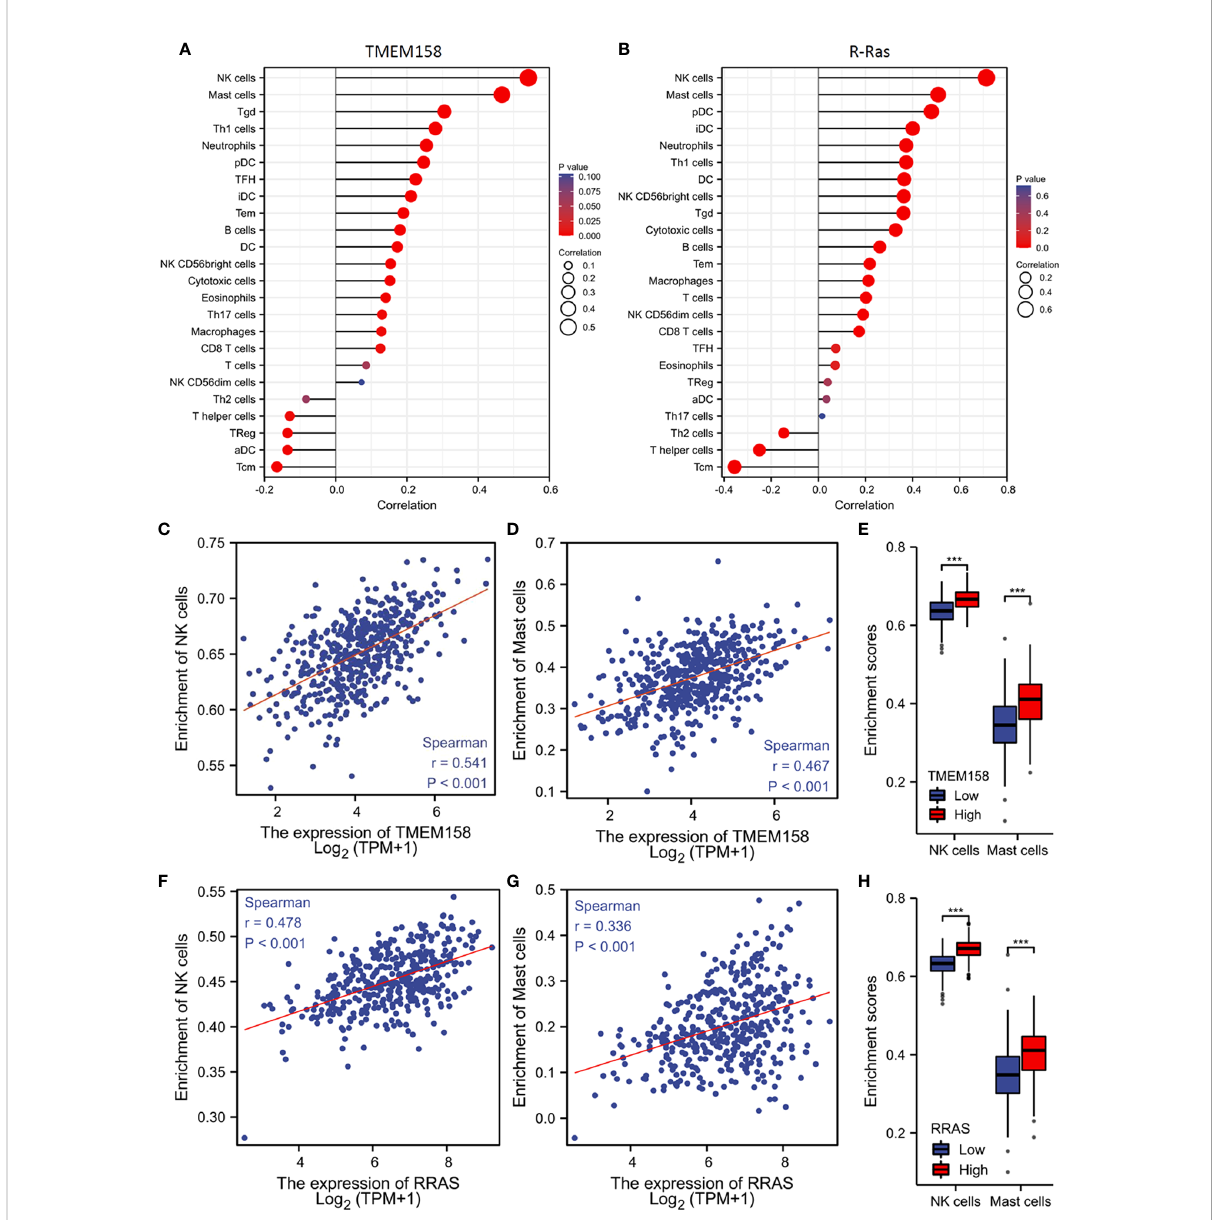
FIGURE 7 TMEM158 expression is associated with anti-tumor immune fi ltration. (A – C) TMEM158 expression data and immune fi ltration pro fi les were extracted from the TCGA-PRAD RNA-seq dataset. The bar graphs were generated using the ssGSEA method. Immune cell category: DC, dendritic cell; aDC, activated DC; iDC, immature DC; pDC, plasmacytoid DC; B cells; CD8 T cells; Cytotoxic cells; Eosinophils; Macrophages; Mast cells; Neutrophils; NK, natural killer cells; NK CD56bright cells; NK CD56dim cells; T cells; T helper cells; Tcm, T central memory; Tem, T effector memory; Tfh, T follicular helper; Tgd, T gamma delta; Th1, T helper-1 cells; Th2 cells; Th17 cells; Treg, T regulatory. (D – F) Spearman correlation analysis was conducted using the TCGA-PRAD RNA-seq dataset. (G – I) Immune fi ltration enrichment scores were extracted from the TCGA-PRAD dataset. Patients were divided into groups with TMEM158 low or TMEM158 high expression levels at the median level. The asterisk indicates a signi fi cant difference compared to the benign group (Wilcoxon rank sum test, ***p <